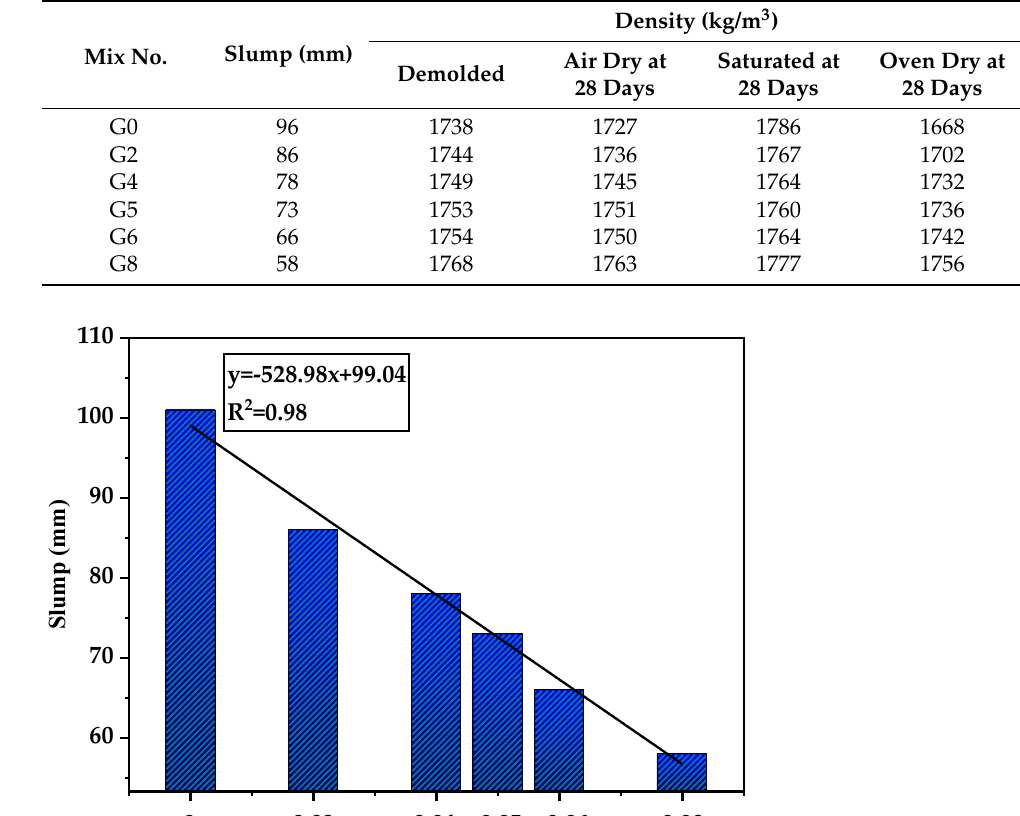
Table 5. Slump and density of concrete mixes.